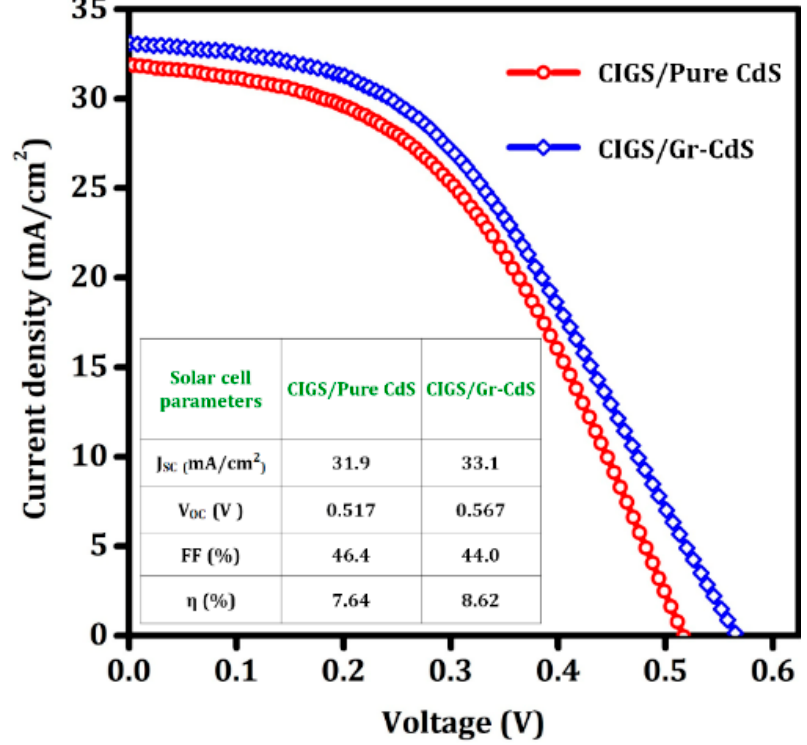
Figure 8. Current density–voltage characteristics of the CIGS/CdS and CIGS/Gr–CdS solar cells.